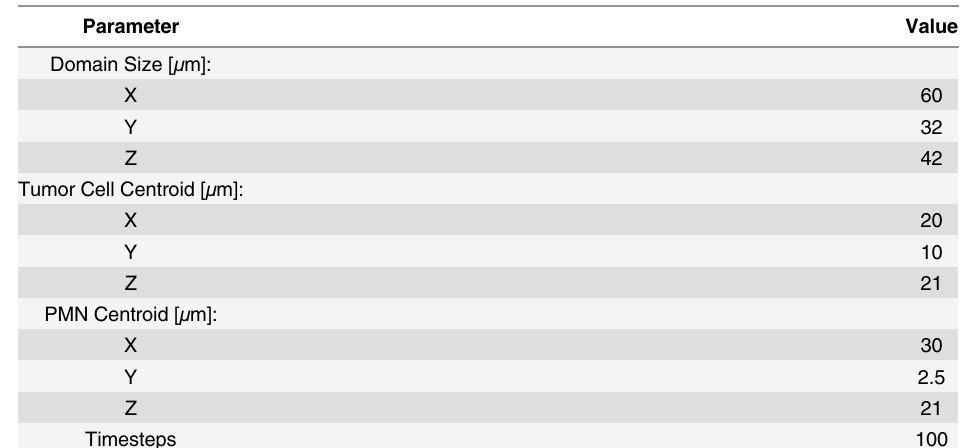
Table 2. Simulation Initial